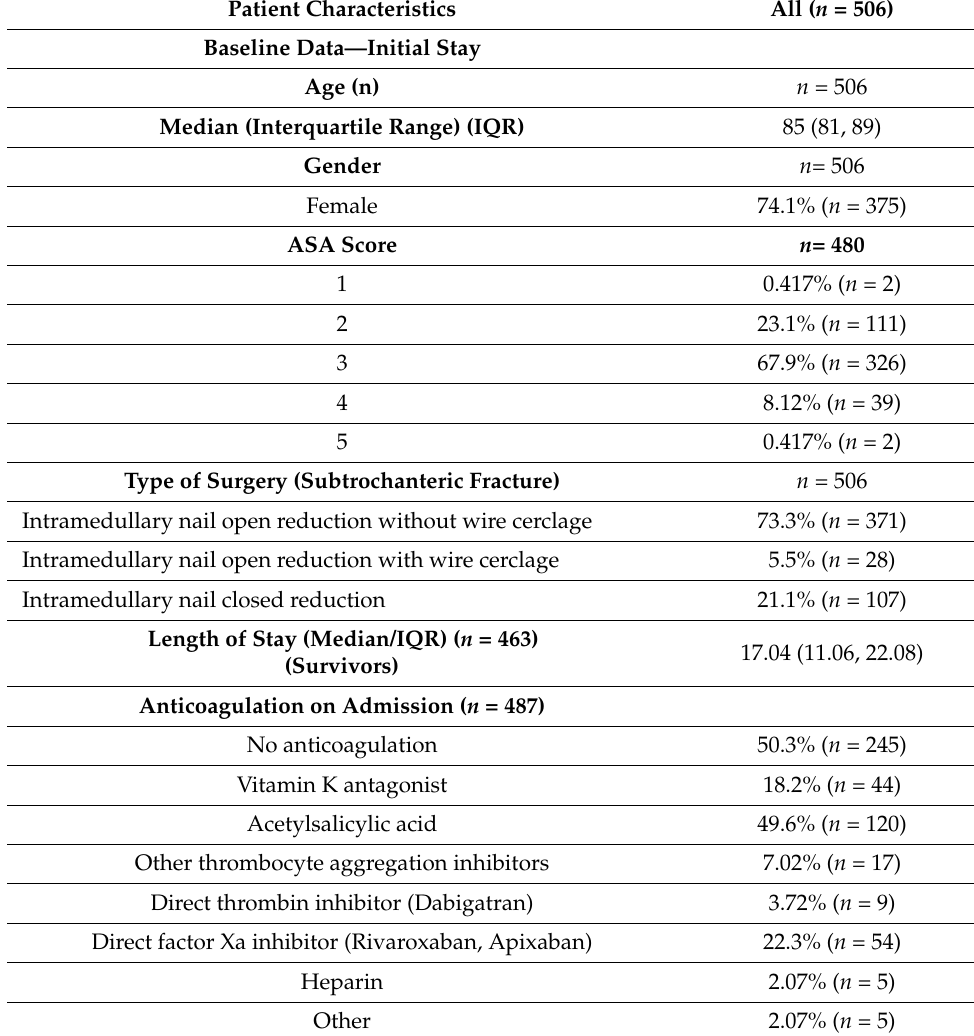
Table 1. Baseline